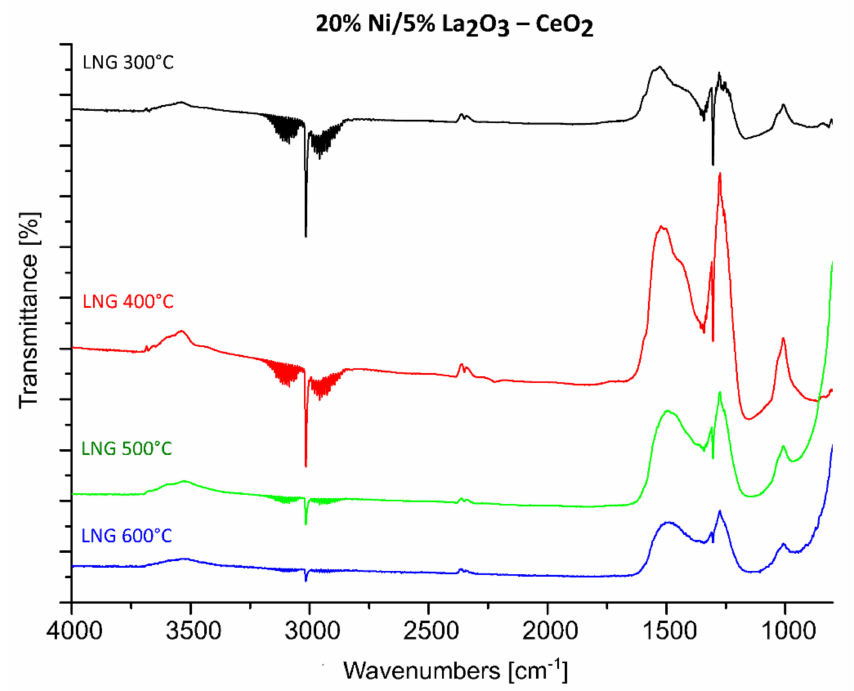
Figure 8. In situ IR spectra under LNG decomposition process conditions in the temperature range